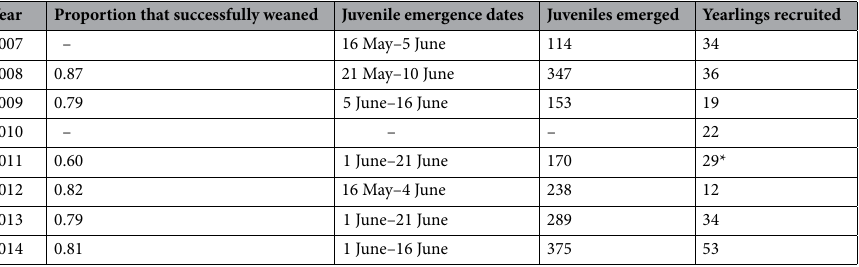
Table 1. The proportion of female Richardson’s ground squirrels ( Urocitellus richardsonii ) that successfully weaned litters (the number of females that successfully weaned litters divided by the number of females that mated), the number of male and female juveniles emerged at the Assiniboine Park Zoo in Winnipeg, the dates of juvenile emergence, and the number of female yearlings recruited into the population, Canada between 2007 and 2014. *Number of yearling females inferred based on body weight at first capture since juveniles were not marked in the previous